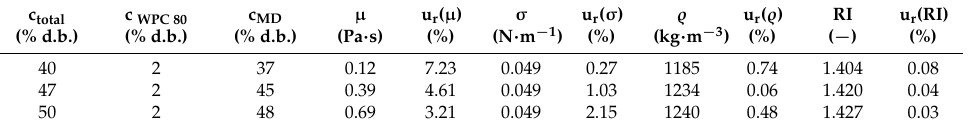
Table 1. Physical properties of test solutions at 25 ◦ C: viscosity ( µ ), surface tension ( σ ), density ( (cid:36) ), and refractive index (RI), as well as the corresponding uncertainty values u r (x) [14]. Concentrations of total dry matter c total , Maltodextrin (c MD ), and WPC 80 (c WPC 80 ) are given as dry base values (d.b.) in weight